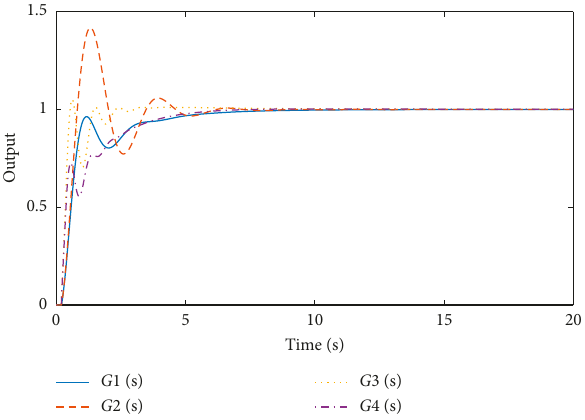
Figure 12: Step response comparison of various methods for example C.